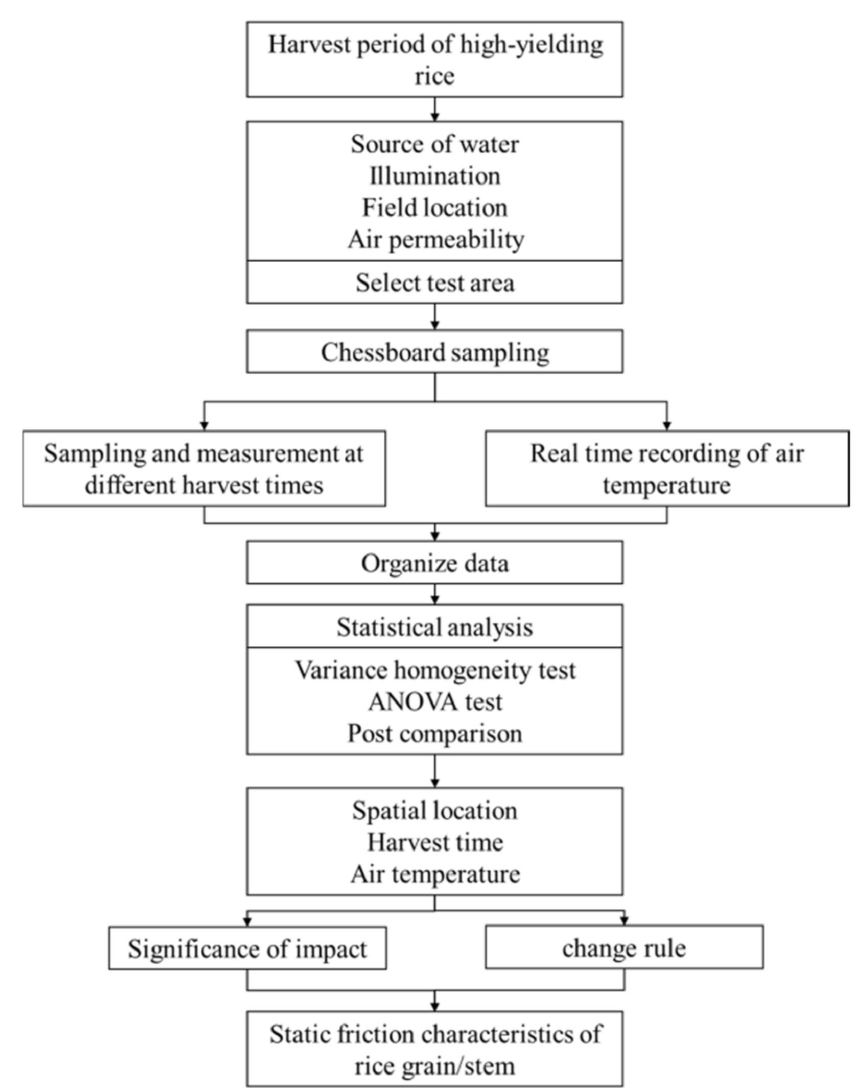
Figure 4. Flow-chart of determining the static friction coefficients of the field high-yielding rice. Due to the field distribution test under different periods being too cumbersome, it is not conducive to statistical analysis. The average static friction coefficients of the rice grains/stems averaged over the three measurement periods are shown in Figure 6. The average static friction coefficient of the rice grains is the highest (0.32) and the lowest (0.25) in Figure 6a. The average static friction coefficient of the rice stems is the highest (0.37) and the lowest (0.33) in Figure